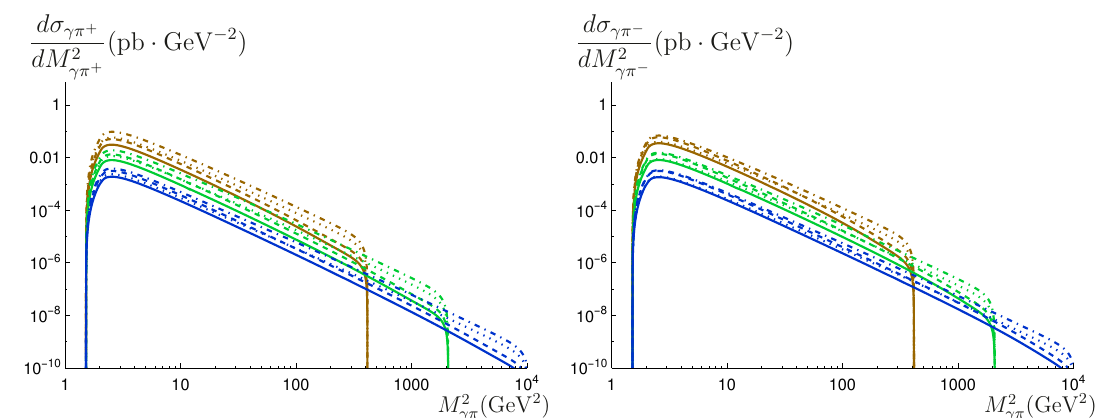
on the γπ . The brown, green and blue curves correspond to S = γN γN . Note that both axes are γN